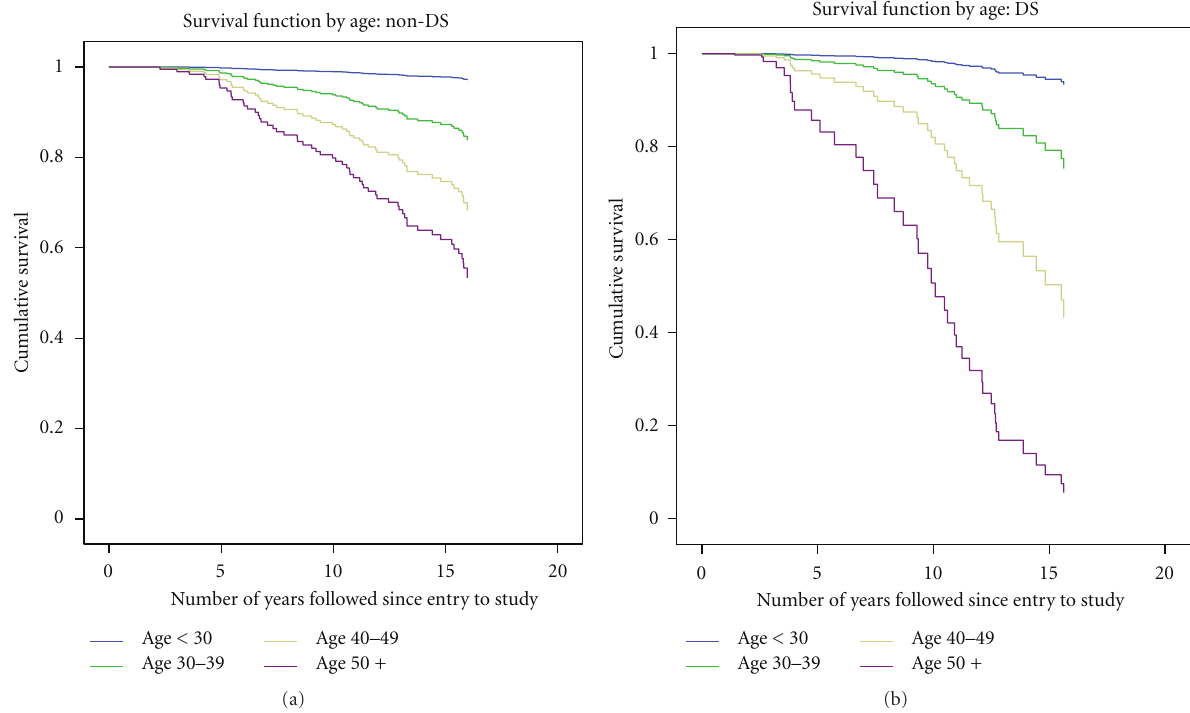
Figure 3: Adjusted survival curves of 360 participants with ID (1995–2011): impact of baseline age: non-DS compared to DS.